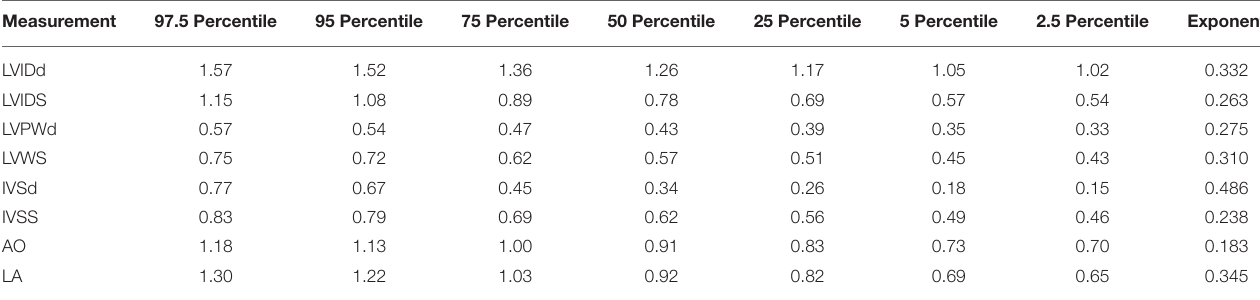
TABLE 2 | List of constant terms for indexing the M-mode measurements and scaling exponents from the allometric models for calculating prediction intervals of the toy breed dogs ( n = 86). Measurement